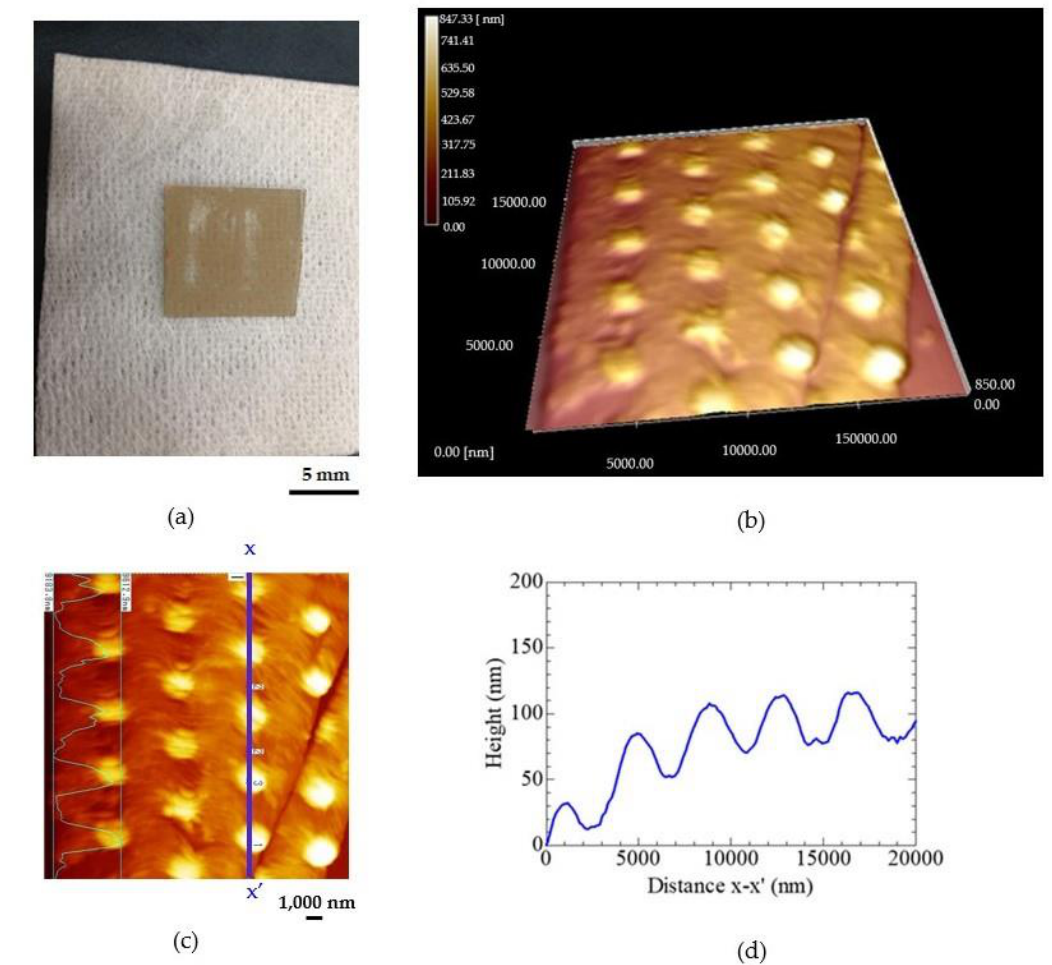
Figure 6. ( a ) Gold thin film on a quartz glass substrate after transfer imprinting method; ( b ) top view of the AFM topography image of the gold micro-disk arrays; ( c ) three-dimensional of the AFM topography image; ( d ) height profiles.